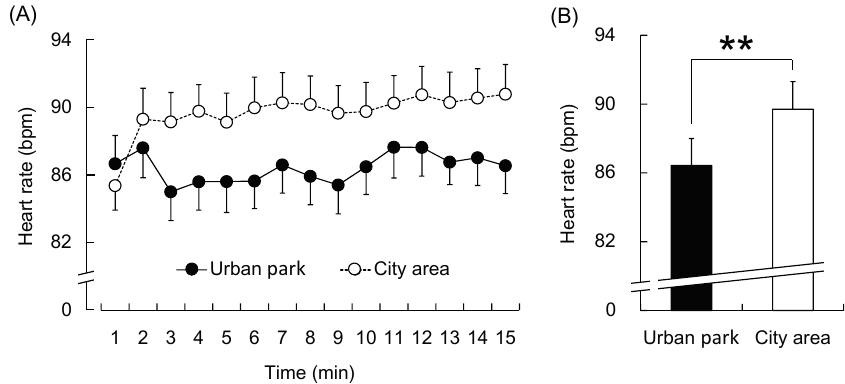
Figure 5. The 1-min averages and the overall mean heart rate during the urban park walk and the city area walk. ( A ) Changes in each 1-min average heart rate over the 15-min walk; ( B ) Overall mean heart rates. N = 20, mean ± standard error. ** p < 0.01, determined by the paired t -test